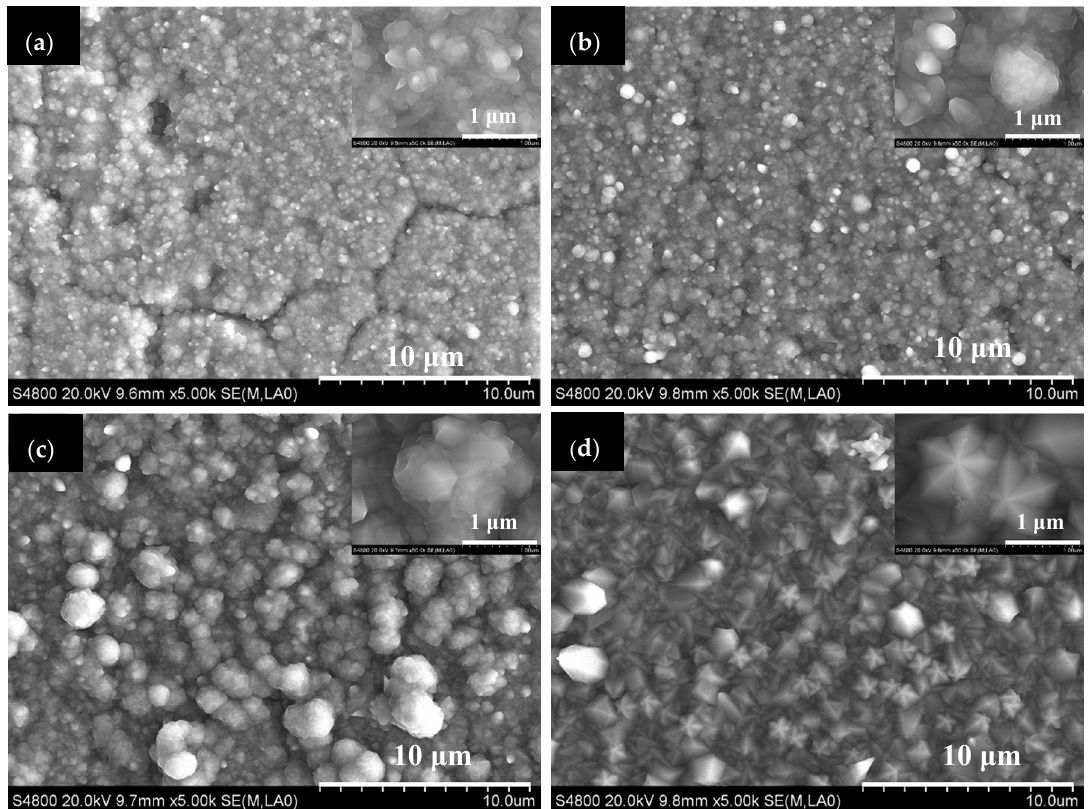
Figure 2. SEM images of TiN coating at 850 °C for 1.5 h at different times of the total flow rate: ( a ) 0.14, ( b ) 0.40, ( c ) 0.71, and ( d ) 1.28 times.